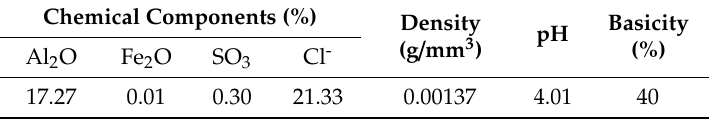
Table 2. Properties of liquid-type polyaluminum chloride (PACl) (provided by the